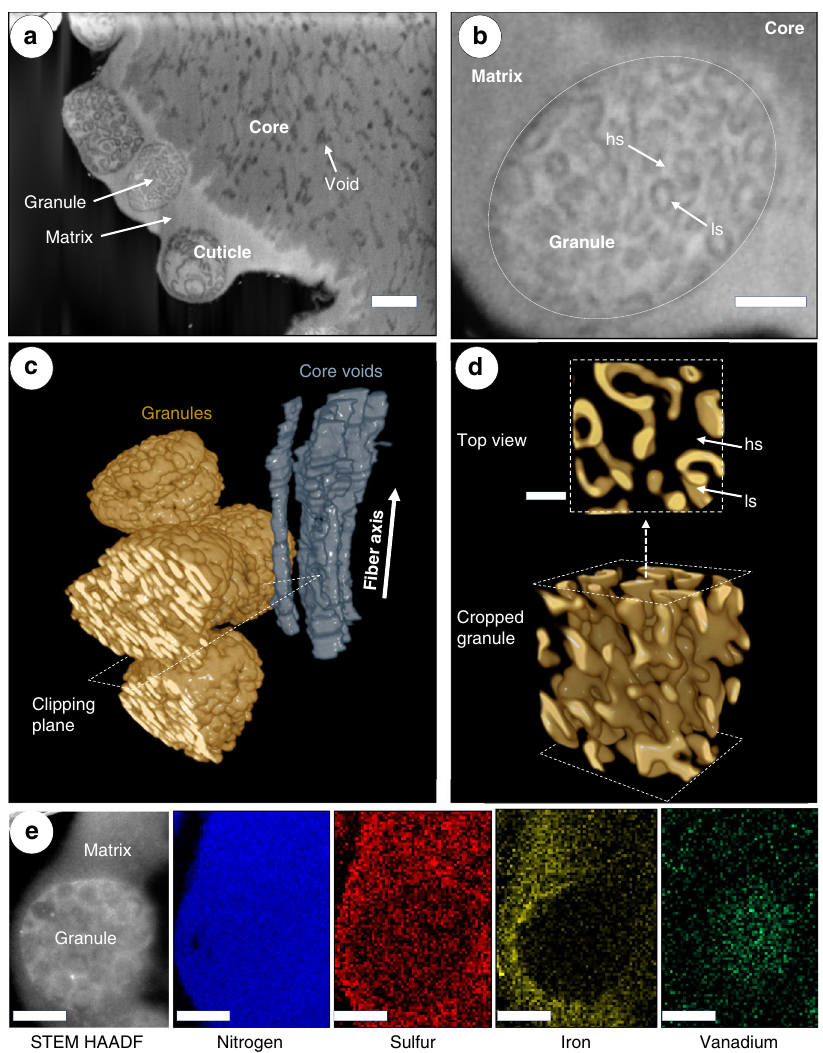
Fig. 4 FIB-SEM 3D-reconstruction of intragranular nanostructure in native thread cuticle. a FIB-SEM image of osmium stained region of native distal thread showing substructure of the core and cuticle, including granule and matrix in the cuticle and previously described voids in the core. Scale bar = 500 nm. b Higher magni fi cation FIB-SEM image of a single granule. Contrast arises from heavily staining (hs) and lightly staining (ls) regions within a single granule. n.b . contrast is inverted compared to TEM, with elements of higher atomic mass appearing brighter. Scale bar = 200 nm. c 3D reconstruction of FIB-SEM image stack using the contrast of the lightly staining (ls) phase of the granules and the core voids (which are parallel to the fi ber axis). d Granule cropped using clipping planes parallel to the one indicated in c revealing internal structure of the ls phase, consisting of bicontinuous fl attened layers with a thickness of ~20 nm. The transparent region between layers constitutes the heavily staining (hs) phase from b . Scale bar = 80 nm. e STEM-EDS compositional analysis of native cuticle granule and matrix regions, showing distribution of nitrogen, sulfur, iron, and vanadium in the region in the STEM-HAADF image on the left. Scale bar = 100